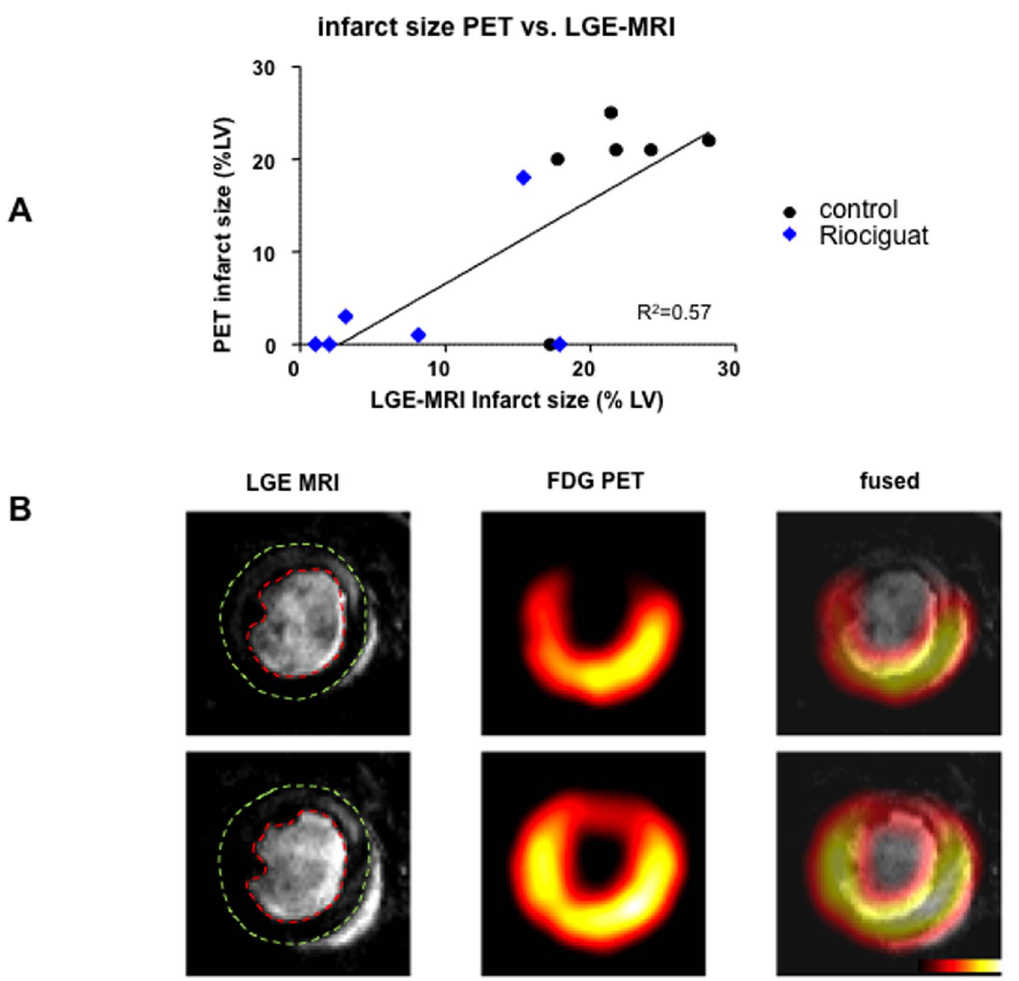
Figure 3. Assessment of infarct size via consecutive LGE-MRI and FDG-PET. ( A ) There was a good correlation between infarct size measured with LGE-MRI and FDG-PET. Acute riociguat treatment at reperfusion (blue) resulted in smaller infarcted areas than untreated controls (black). ( B ) Representative overlay images of LGE-MRI and FDG-PET of a mouse in the control group. Eepicardial and endocardial borders have been manually added on the LGE images for clarity. The infarct area, represented by hyperenhancement in the MRI images, matches an area of hypoenhancement on the PET.